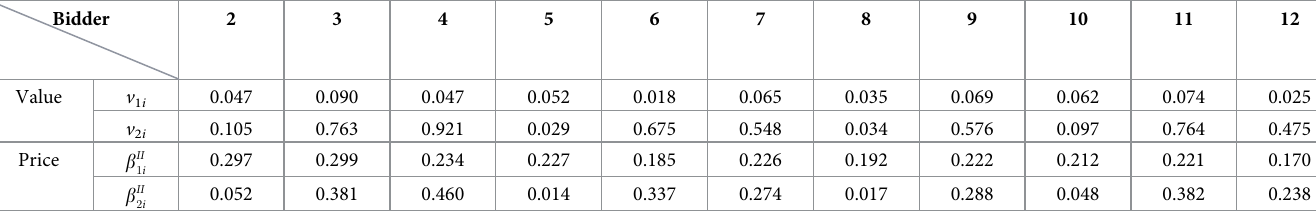
Table 6. Transaction bidding price of bidders for the second-price format.